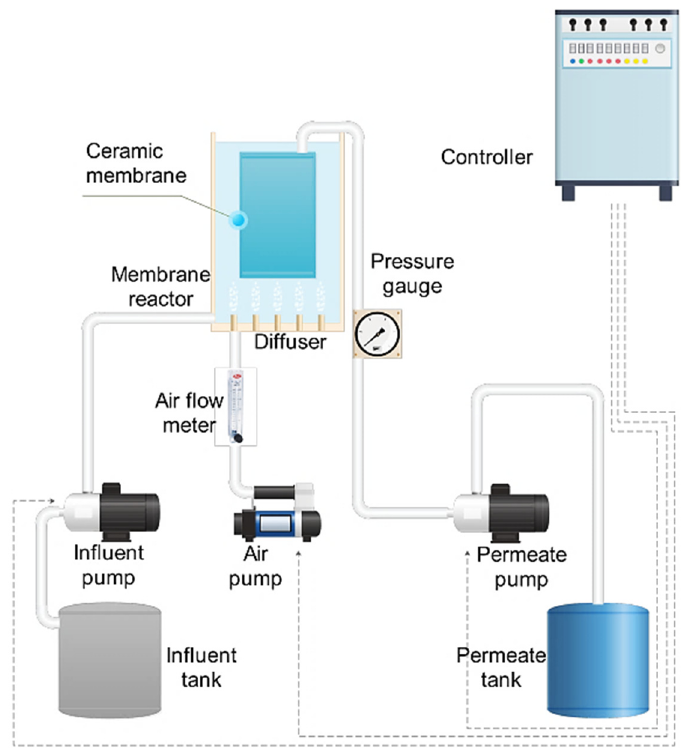
Figure 1. Schematic diagram of the Membrane bioreactor (MBR) experimental setup.